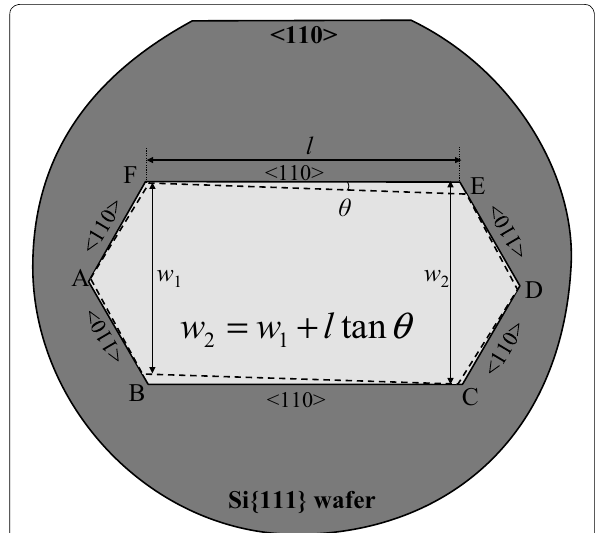
Fig. 3 Effect of misalignment on the size of the structure fabricated using wet anisotropic etching on Si{111} wafer. θ is the misalignment angle of mask edge from 〈 110 〉 crystallographic direction. Dashed lines indicate the edges of original hexagonal shape mask